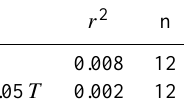
the basic pattern of matter and energy flow in Arctic plankton ecosystems. Both the changes in plankton metabolism (shift from eutrophic to net heterotrophic ecosystem) and the cope- pod energy balance (respiration losses higher than ingestion) appear to take place at relatively low temperature increases (Vaquer-Sunyer et al., 2010).